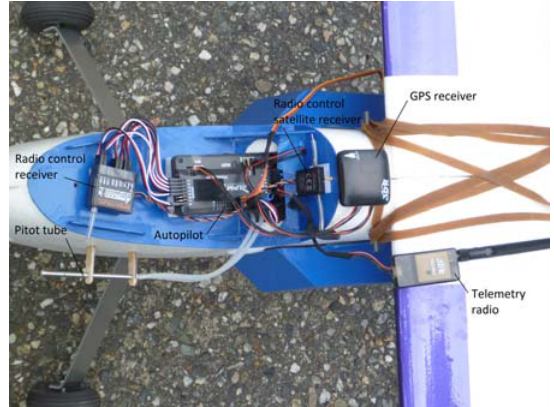
Figure 2. UAV autopilot, sensor, and radio packages